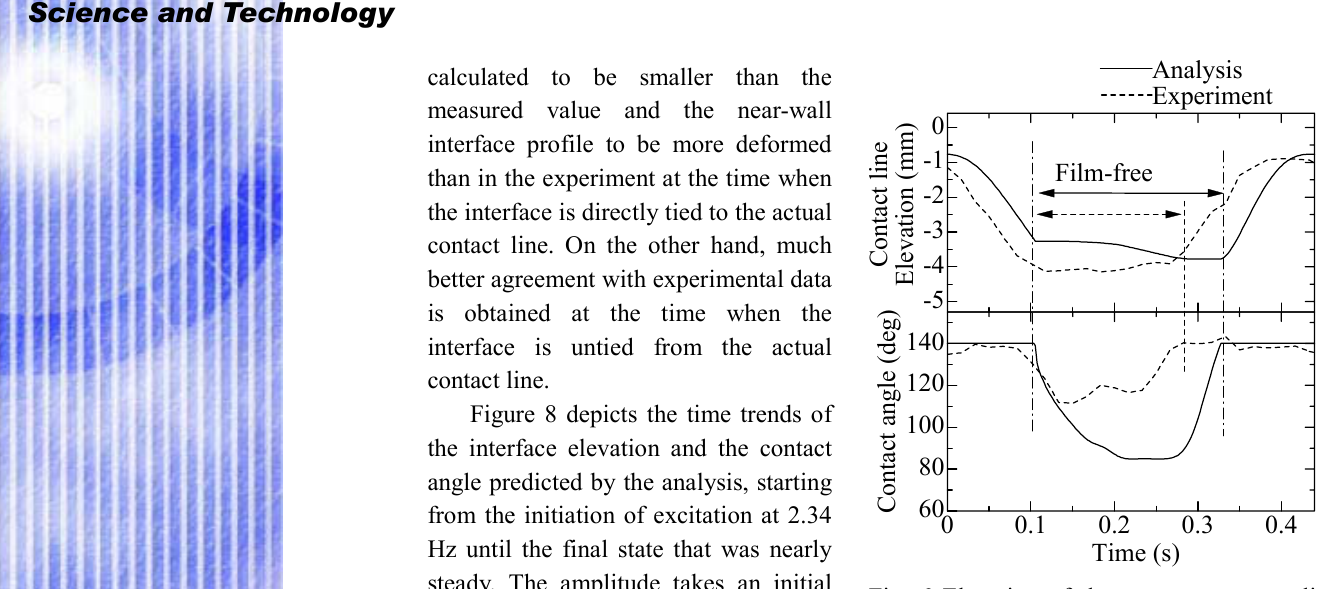
Fig. 6 Elevation of the apparent contact line and apparent contact angle vs. time in one cycle of excitation.